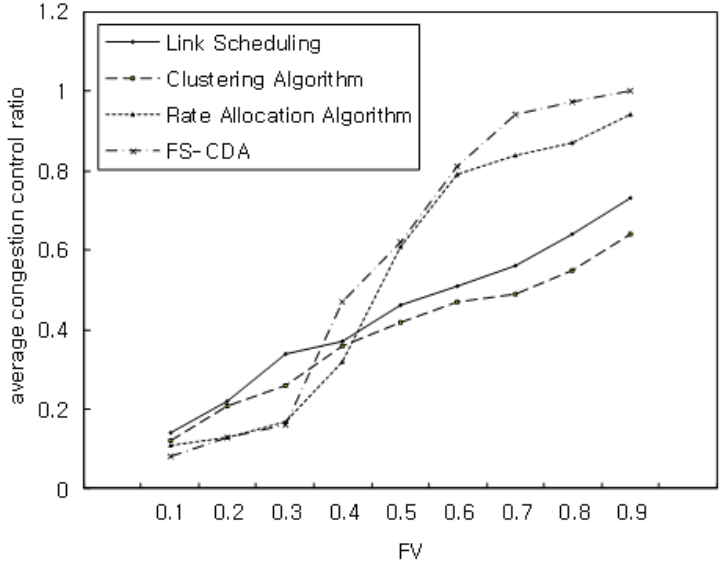
Figure 10. Average congestion control ratio with FV.